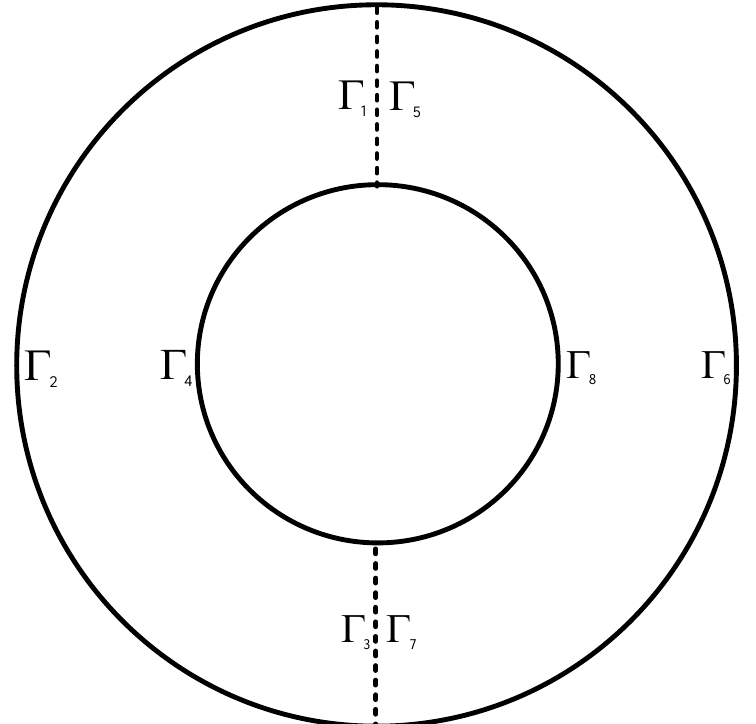
Figure 12. Configuration of sub-boundaries.